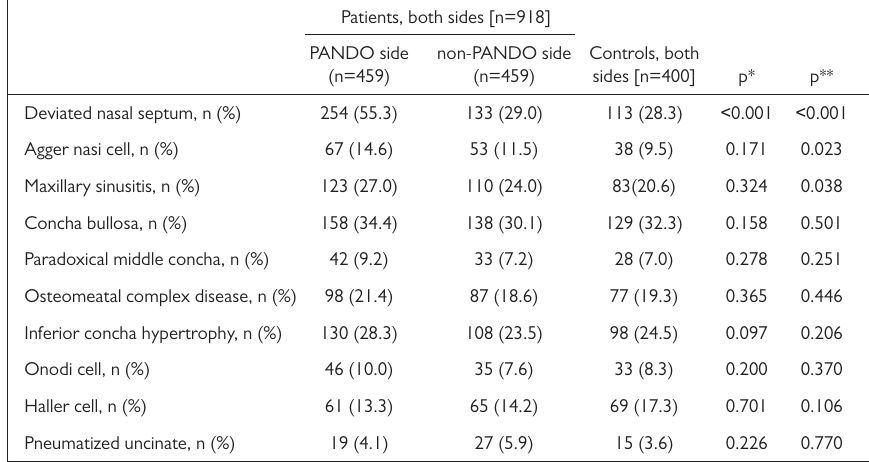
Table 1. Comparison of anatomic and inflammatory/infective variations between patients and con- trols between PANDO sides and non-PANDO sides of the investigated